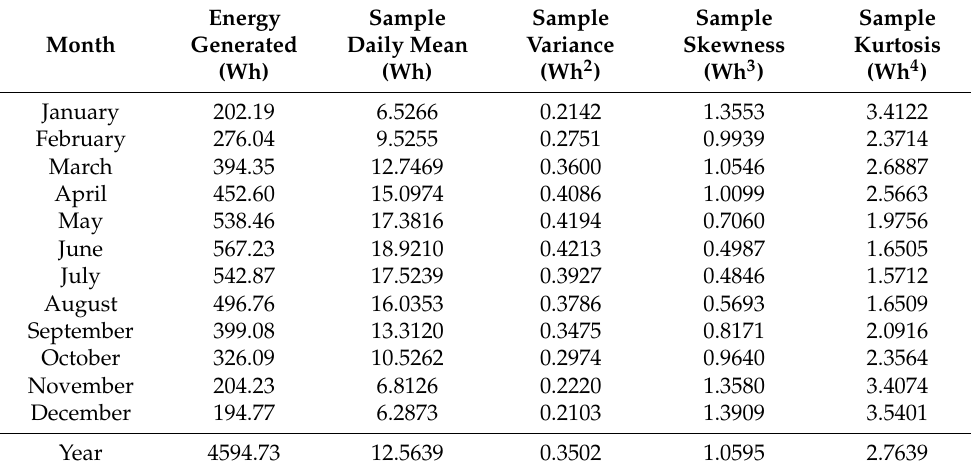
Table 13. Descriptive statistics of the power SP generation in year 2020.